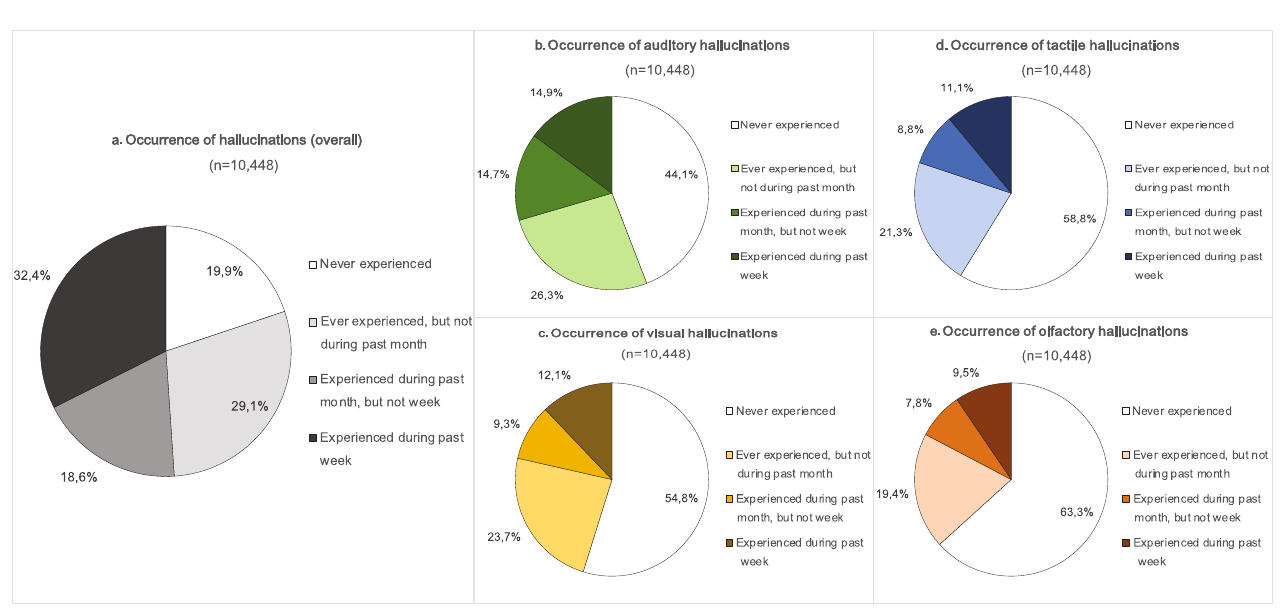
Fig. 1 Occurrence of hallucinations. Based on response to screening items from the QPE in the entire study sample ( n = 10,448), as measured for the auditory (green; b ), visual (yellow; c ), tactile (blue; d ), and olfactory (red; e ) sensory modalities, as well as an overall category combining the occurrence of hallucinations in all four sensory modalities (gray; a